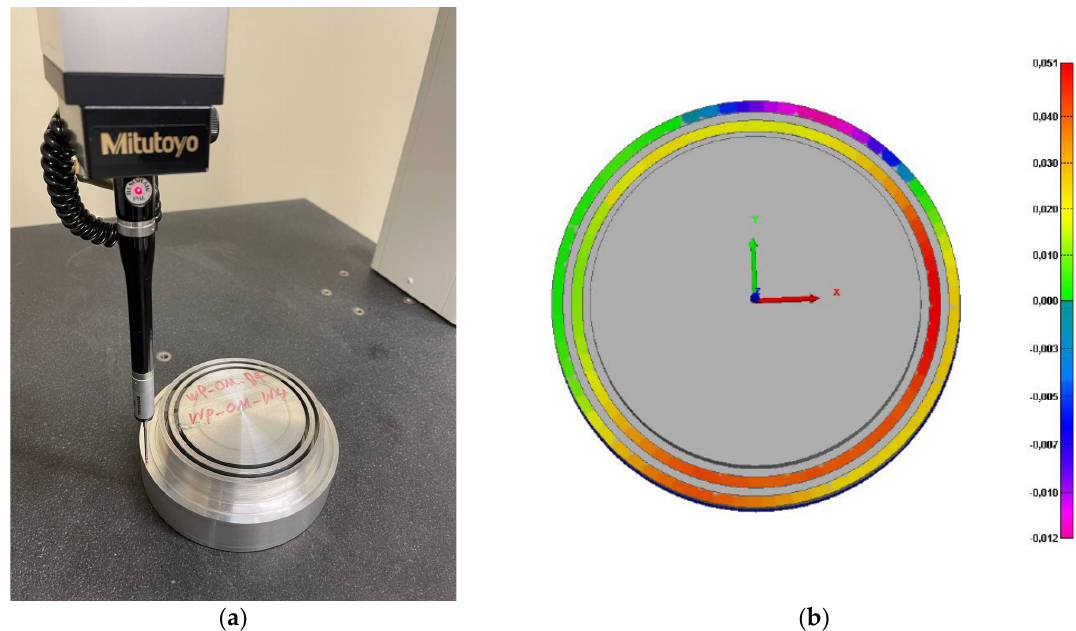
Figure 2. ( a ) Measurement of surface profile of the workpiece using a coordinate measuring machine and ( b ) the map of the surface profile.